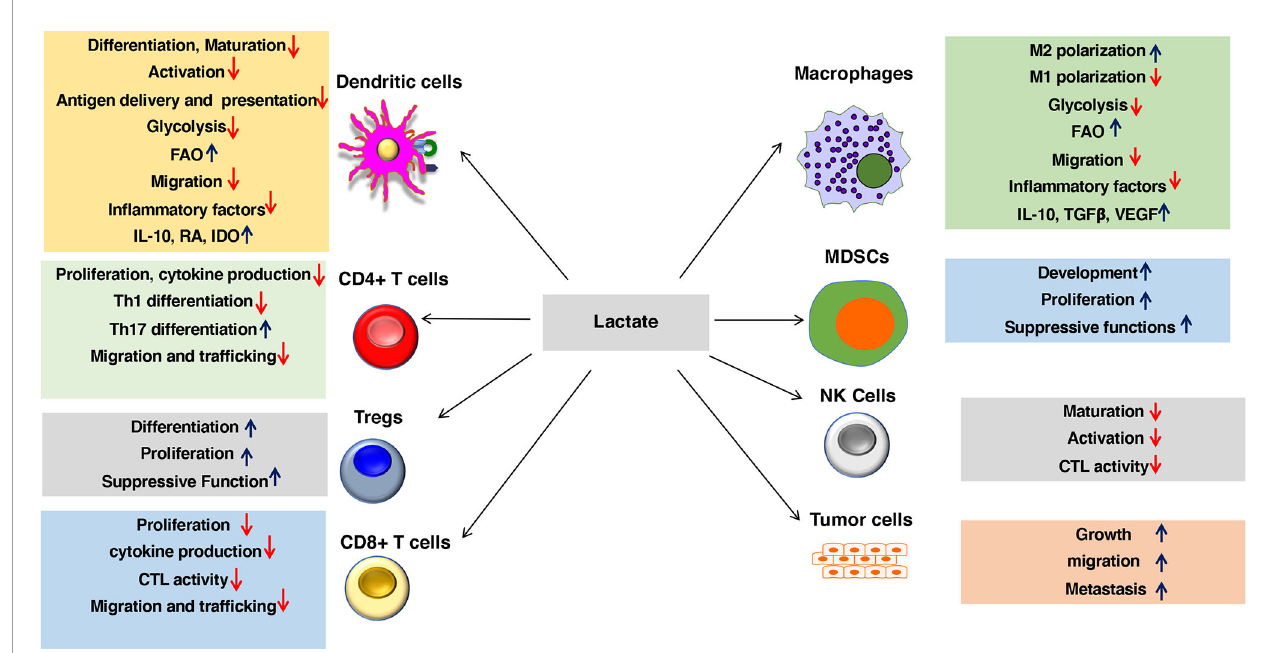
FIGURE 2 | Lactate in the environment shapes the functions of both innate and adaptive immune cells. Lactate promotes anti-in fl ammatory and antitumor immune responses by modulating DC and macrophage functions such as activation, traf fi cking, capturing, and cross-presenting antigens and expression of immune regulatory and in fl ammatory factors. Besides, lactate signaling cascade directly shapes the activation, proliferation, and effector phenotypes of myeloid-derived suppressor cells (MDSCs), Tregs, CD4 + T cells, CD8 + T cells, NK cells, and other immune cells. Lactate also regulates traf fi cking and migration of immune cells to tissues and draining lymph nodes (DLNs) by regulating chemokine receptors as well as synthesis and secretion of chemokines. Lactate signaling in the immune cell leads to metabolic alterations in DCs and macrophages that programs them to a regulatory state. Lactate-mediated signaling shifts metabolism of DCs and macrophages from glycolysis to fatty acid oxidation (FAO). Besides, lactate signaling in tumors and macrophages promotes tumor growth, migration, and